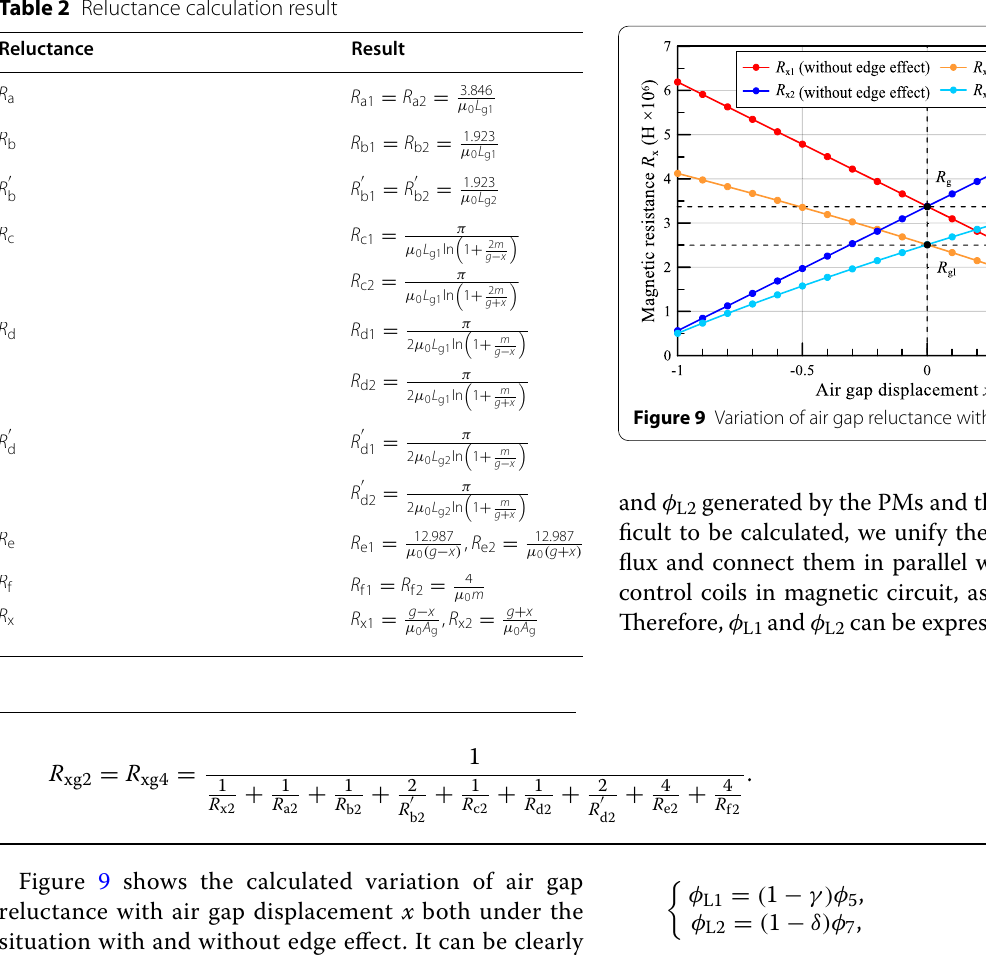
where γ represents the flux utilization of PM, and δ repre- sents the flux utilization of control coil. Finally, the whole equivalent magnetic circuit diagram of the REMC-NFM is shown in Figure 10. The black solid line represents the magnetic circuit, the rounded rectangle represents the magnetic reluctance, and the arrow represents the direc- tion of the magnetic flux. The purple dashed box contains all the air gap magnetic reluctance considering the edge effect, and the blue dashed box contains the same type of magnetic flux